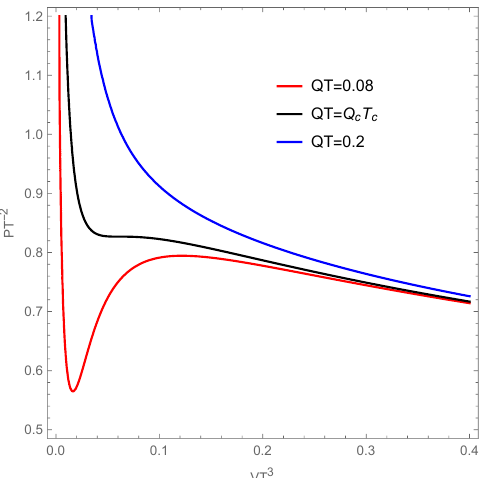
Figure 9 . The equations of state for a RN black hole in a cavity for di(cid:11)erent values of QT . The isotherms with (cid:12)xed Q bear a striking resemblance to those of the Van der Waals (cid:13)uid. The oscillating behavior below Q c T c is reminiscent of the liquid/gas phase transition of the Van der Waals